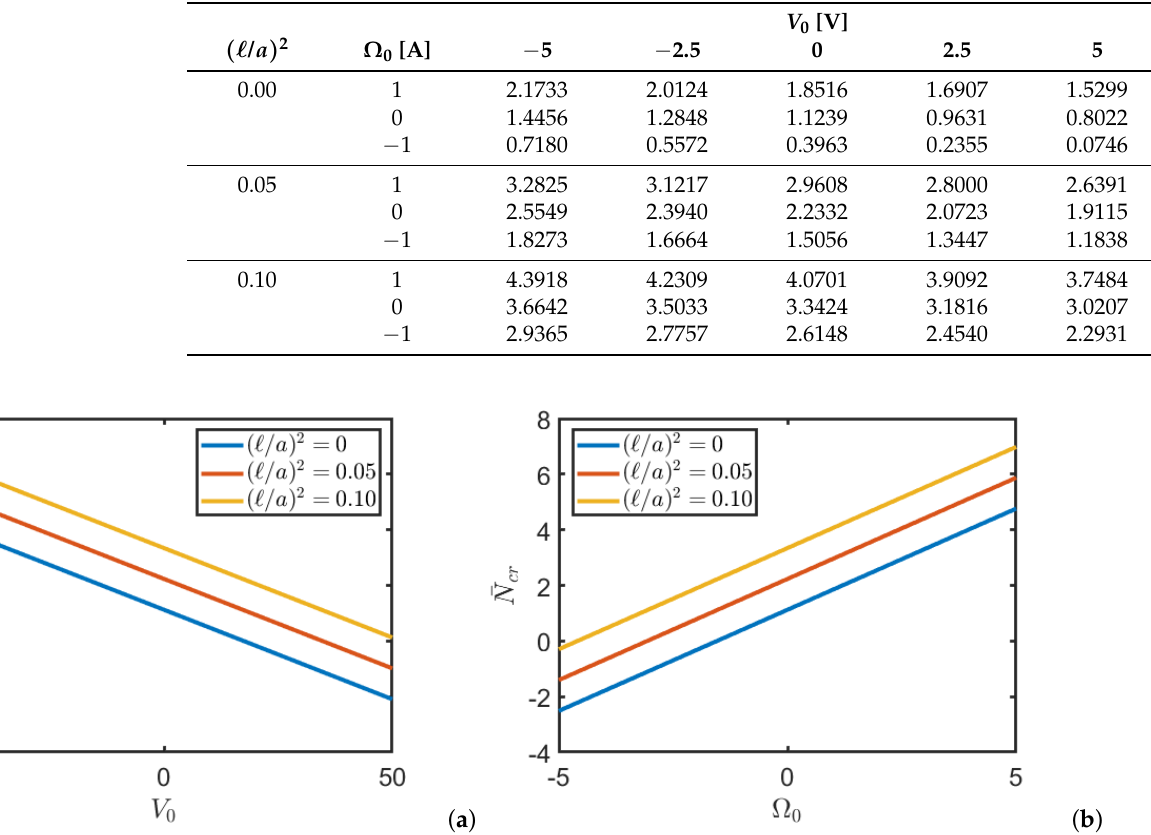
Figure 3. Critical load ¯ N cr of a square FG nanoplate for different values of electric potential V 0 ( a ) and magnetic potential Ω 0 ( b ), for different values of non local parameter ( (cid:96) / a ) 2 .